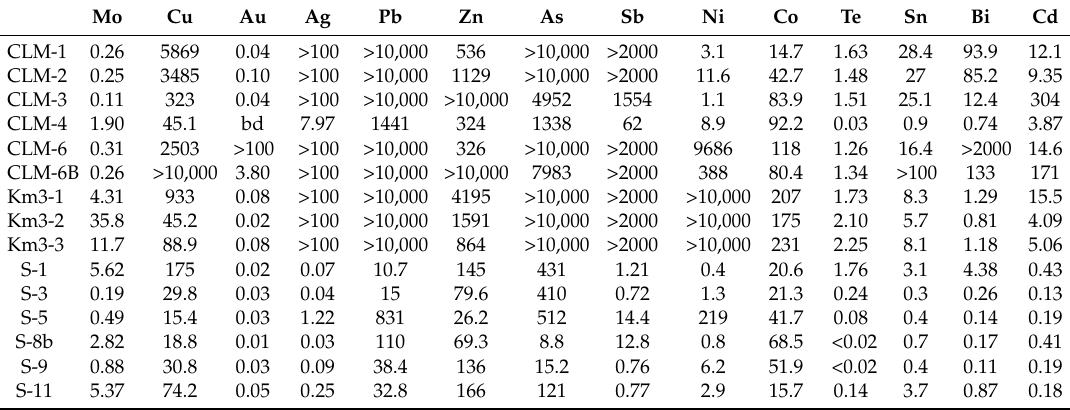
Table 2. Trace element content (in ppm) of mineralization in the Clemence (CLM-series) and “km3” (Km3-series) deposits, and porphyry-style mineralized Serpieri (S-series) dikes. bd = below detection. Mo CLM-1